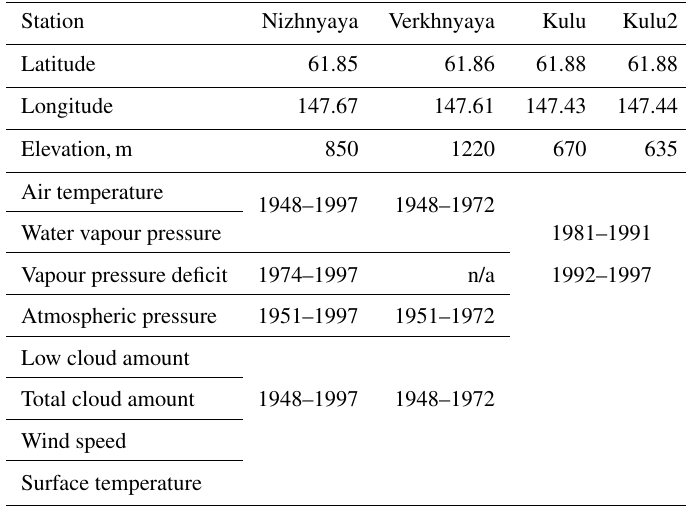
Table 1. List of meteorological observation data. n/a – not applicable.